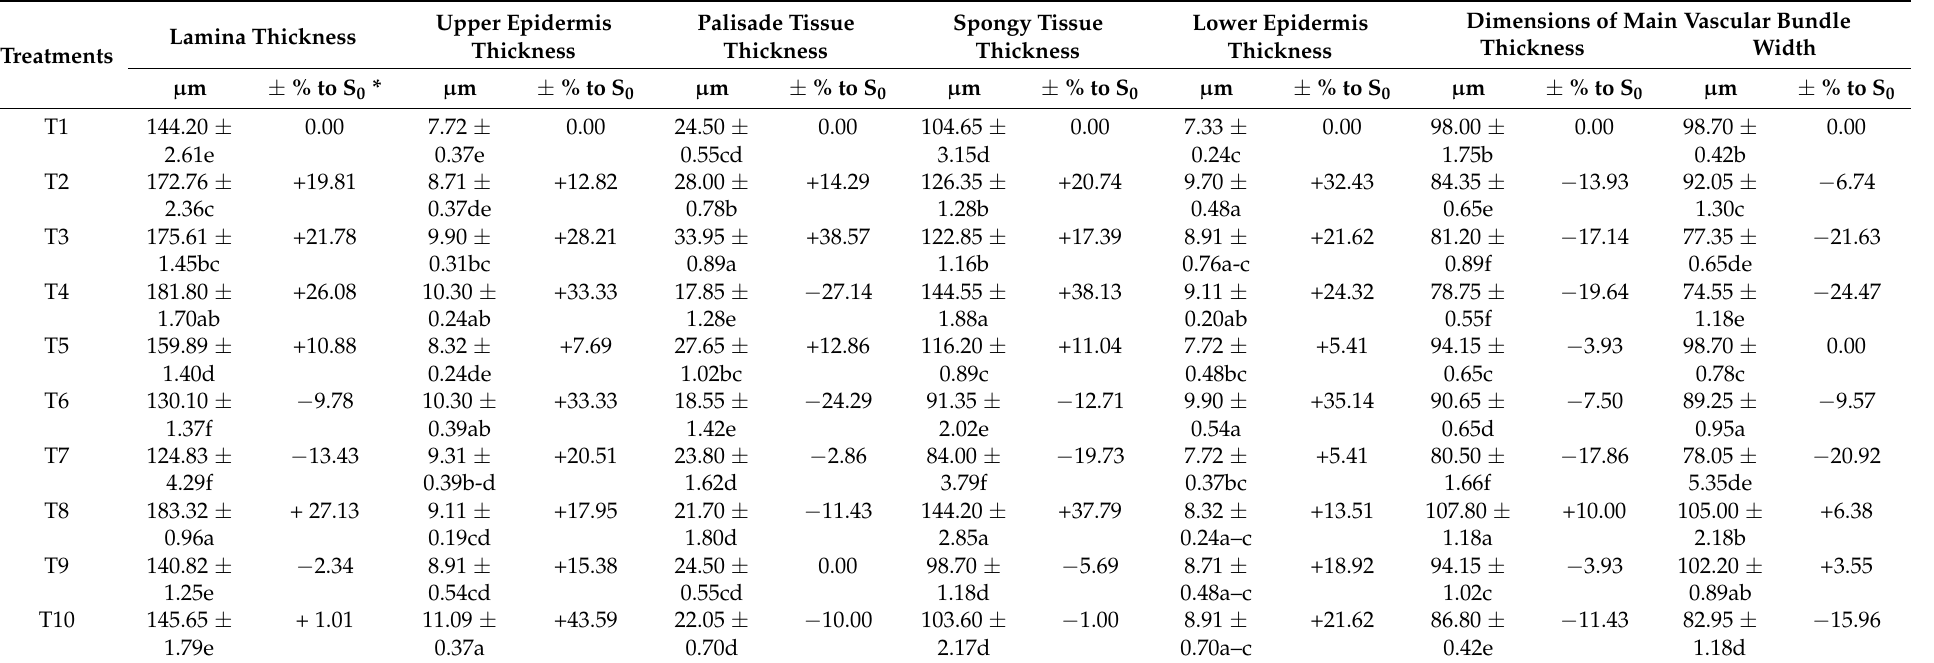
Table 1. Anatomical modification of jojoba leaves as affected by seawater salinity and exogenous proline. Data are means of the second season (2021) and five replicates ( n = 5). The mean values ± SE of each parameter in the same column followed by different alphabetical letters are significantly different according to Duncan’s multiple range test at p ≤